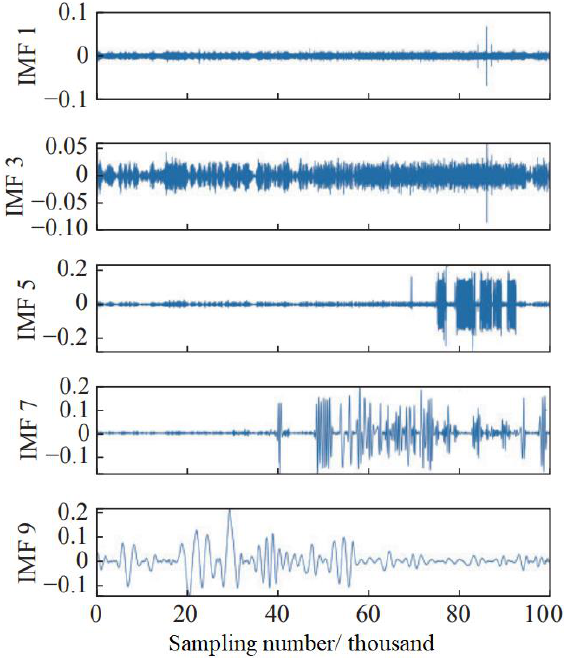
Figure 9. EMD decomposition diagram of interference signal.